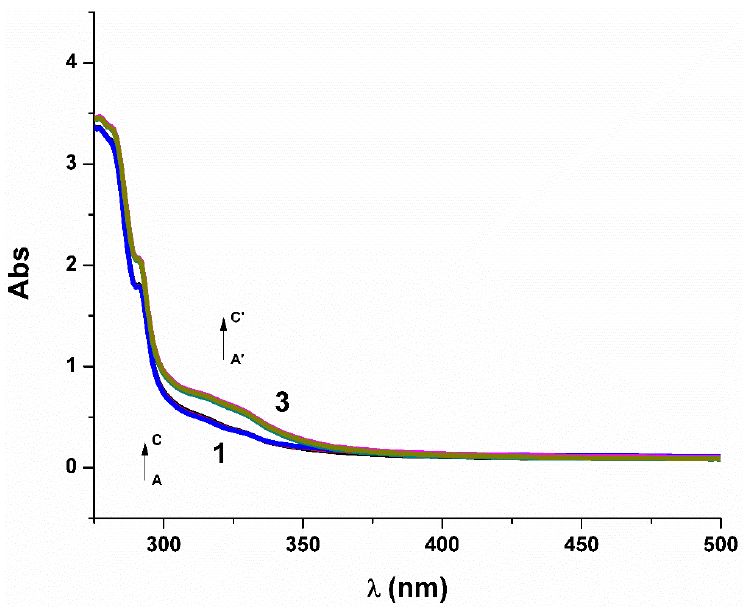
Figure 7. UV–vis spectra of 1 ppm complexes 1 and 3 taken in acetonitrile with the presence of 0.5% v / v BPS (pH 7.0) at room temperature.